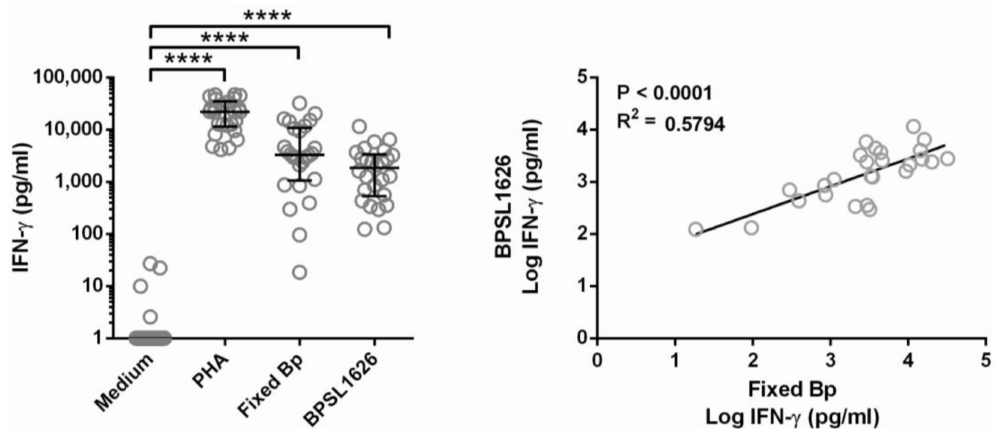
Figure 2. BPSL1626 induces IFN- γ production from healthy whole blood and correlates to the response from PFA-fixed B. pseudomallei . The left panel shows the IFN- γ released from whole blood from healthy donors, following incubation with medium alone, 3 µ g/mL PHA, 5.4 × 10 6 colony-forming units (CFU) paraformaldehyde (PFA)-fixed Bp, or 10 µ g/mL BPSL1626 for 48 h, as described in the Methods section. IFN- γ levels in supernatants were quantified by ELISA; results are shown as individual scatter dot plot line at median with interquartile range. Statistical differences were determined using one-way ANOVA with Dunn’s multiple comparisons test or the Pearson correlation; **** p < 0.0001. The right panel shows the linear correlation between the Log IFN- γ production induced by BPSL1626 in comparison with PFA-fixed Bp, analyzed by the Pearson correlation